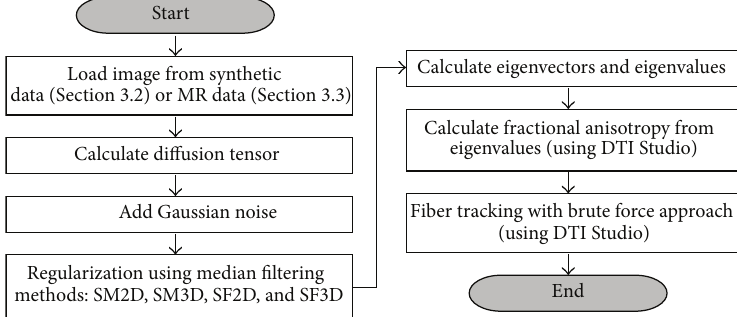
Figure 4: Flowchart of the fiber tractography loaded from synthetic data (Section 3.2) or DTI data (Section 3.3).